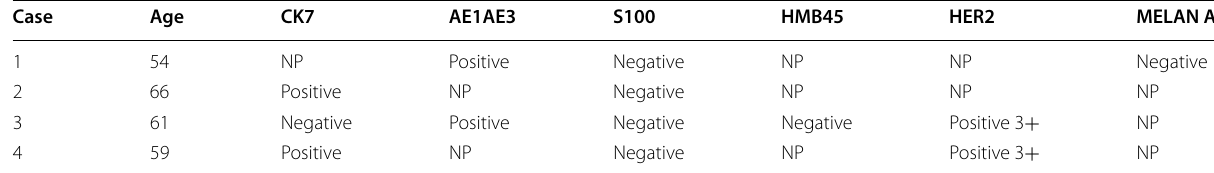
Legend: CK cytokeratin, HMB45 Human Melanoma Black, HER2 Human epidermal growth factor receptor, NP not